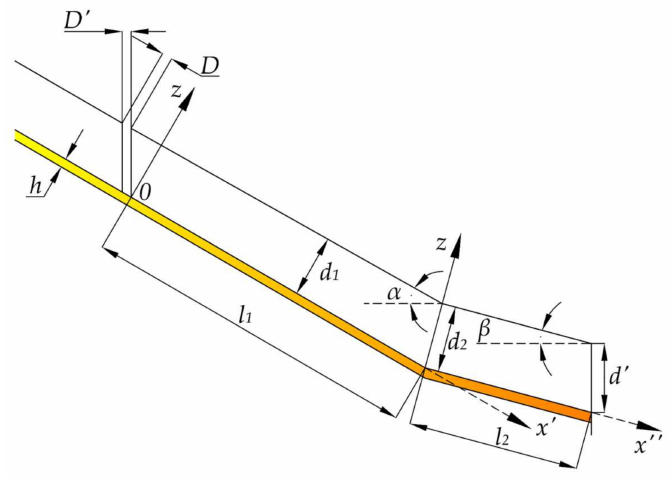
Figure 9. Schematic diagram of various morphological parameters reflecting the stability of thrust- load-induced accumulation landslides induced by rainfall